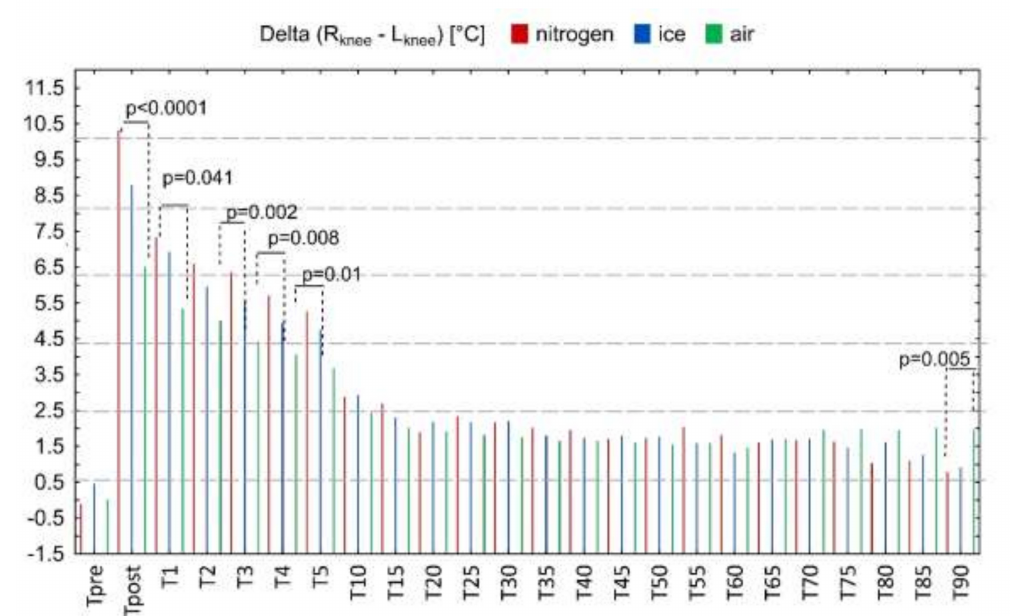
Figure 5. Change in the value of the difference in temperature between the areas of the right (unstimulated) and left (stimulated) knee joint during 90-min observation. Legend: p —the level of test probabilities for one-way ANOVA for the differences between liquid nitrogen vapors, cold air, ice bag at the estimated time point. Data are expressed as mean.